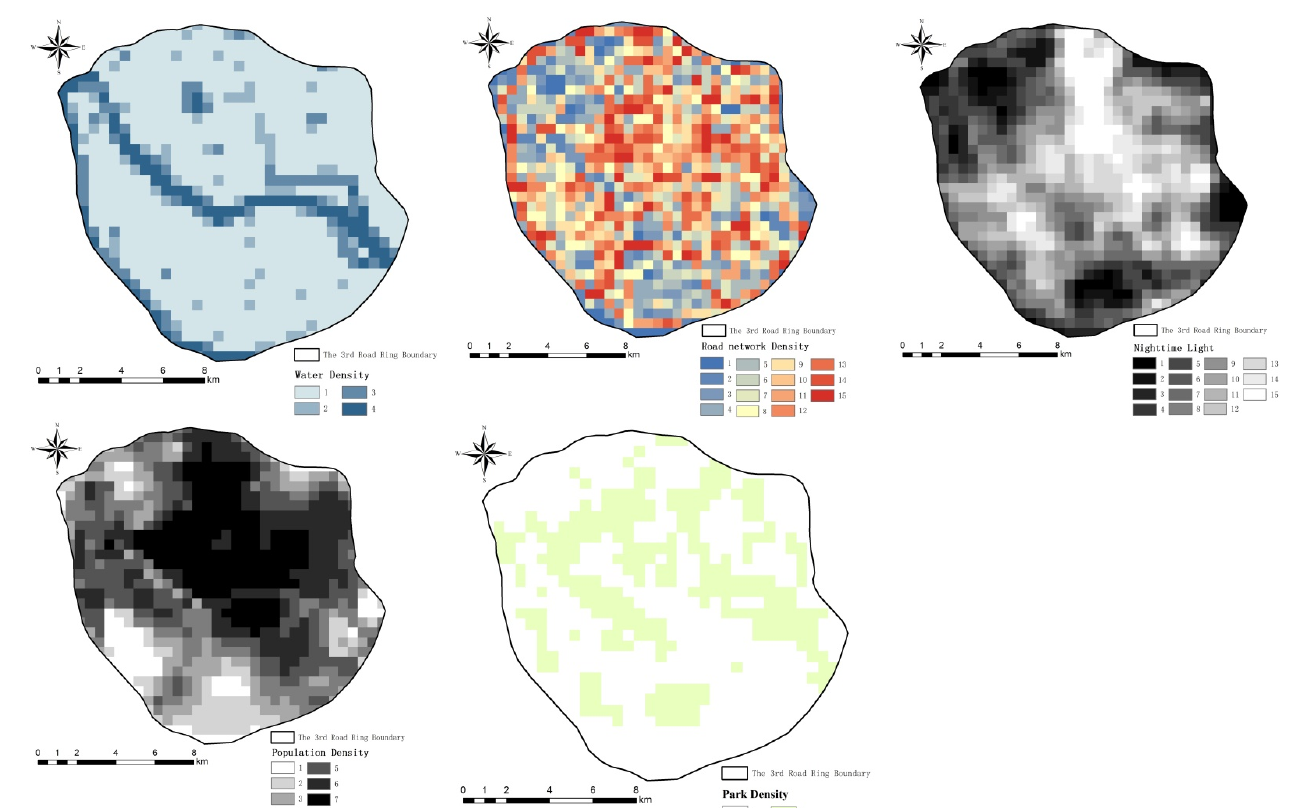
Figure 2. Spatial distribution of 11 driving factors in the study area.